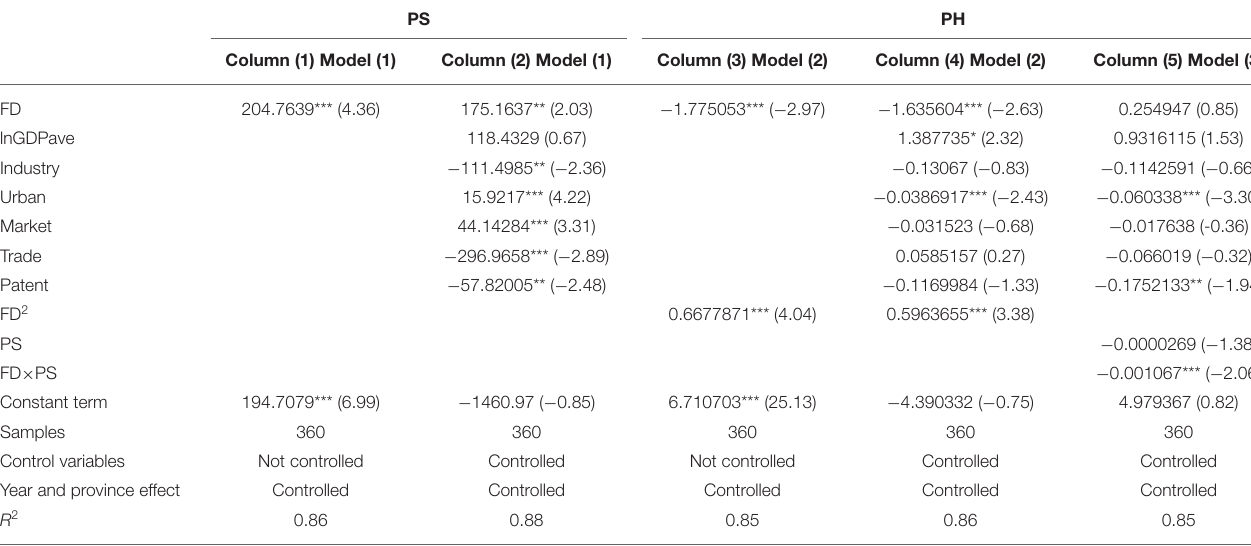
TABLE 3 | Benchmark regression results.